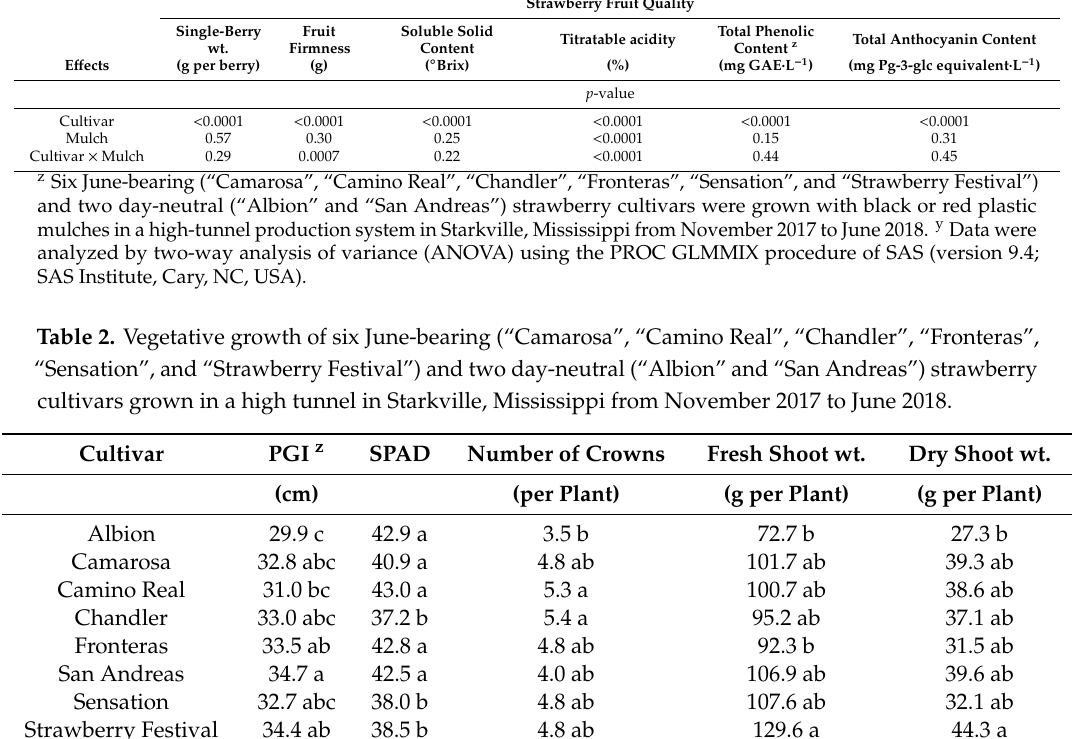
significant di ff erence (HSD) test at p ≤